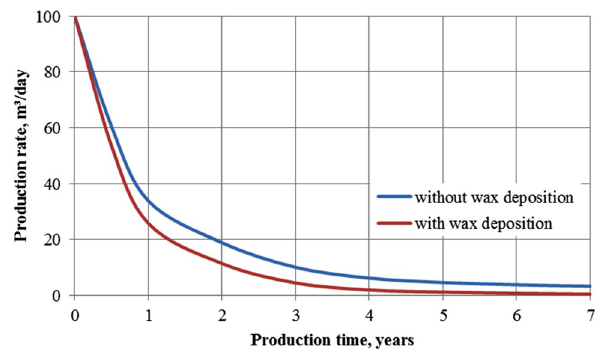
Fig. 13 Production rate without and with wax